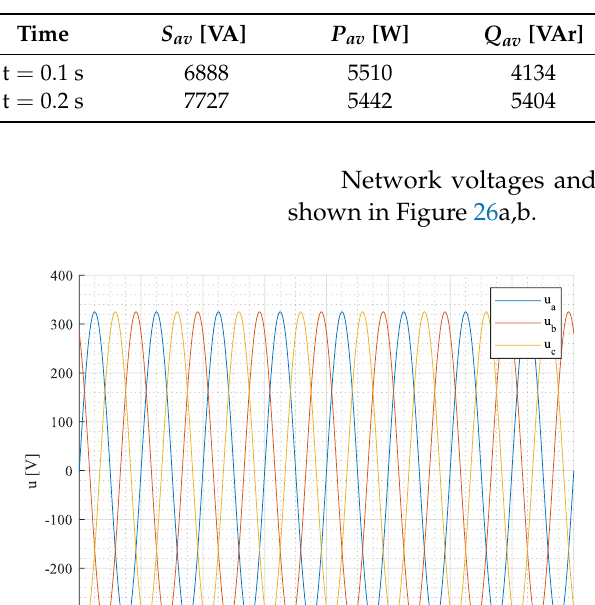
Table 39. Simulation results before and after the change (at steady states).